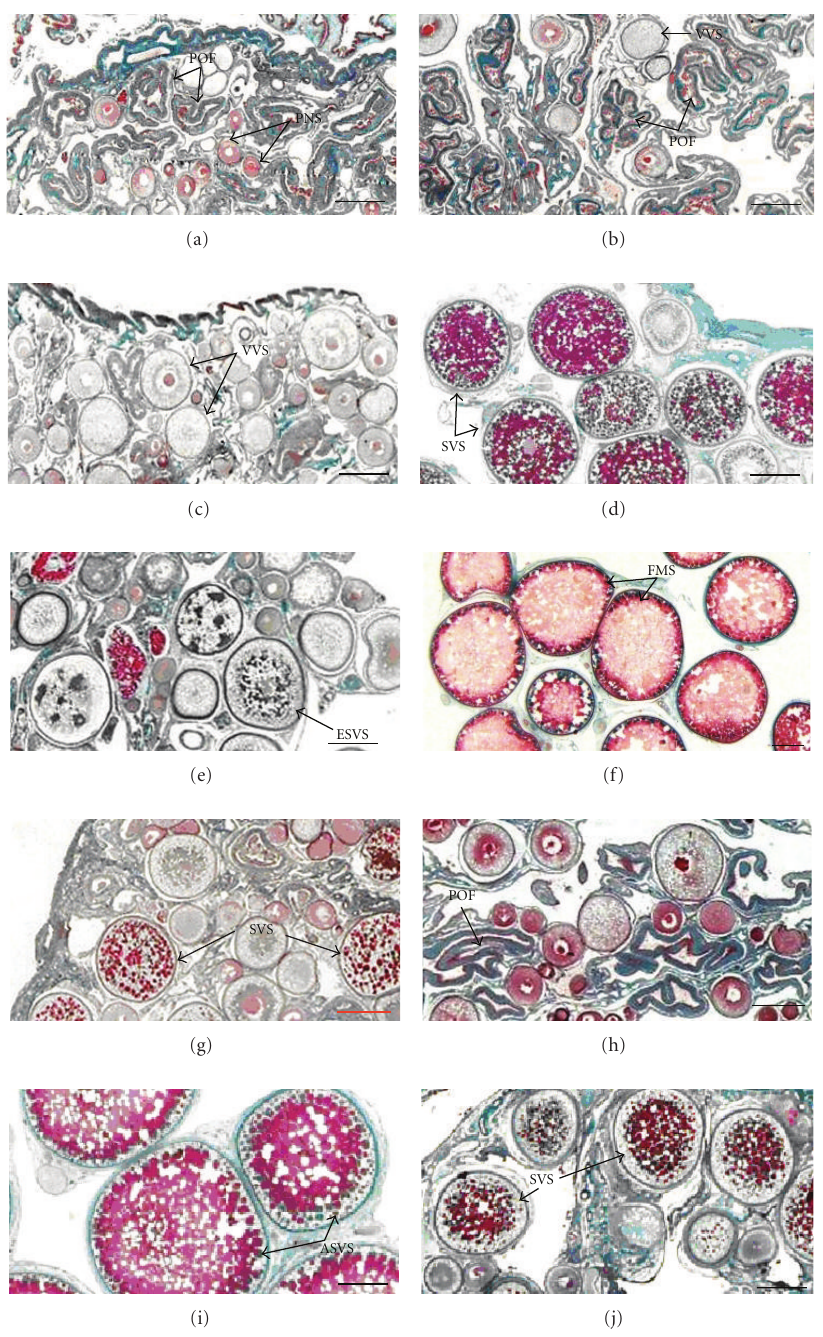
Figure 4: Histological sections of ovaries at di ff erent stages of development during oogenesis. (a), (c), (e), (g), (i): once spawners; (b), (d), (f), (h), (j): twice spawners. (a), (b): May; (c), (d): July; (e), (f): September; (g), (h): November; (i), (j): January. POF: postovulatory follicles; PNS: perinucleolar stage; VVS: vitellin vesicles stage; SVS: secondary vitellogenesis stage; ESVS: early secondary vitellogenesis stage; FMS: final maturation stage; ASVS: advanced secondary vitellogenesis stage. Bar scale represents 1,000 μ